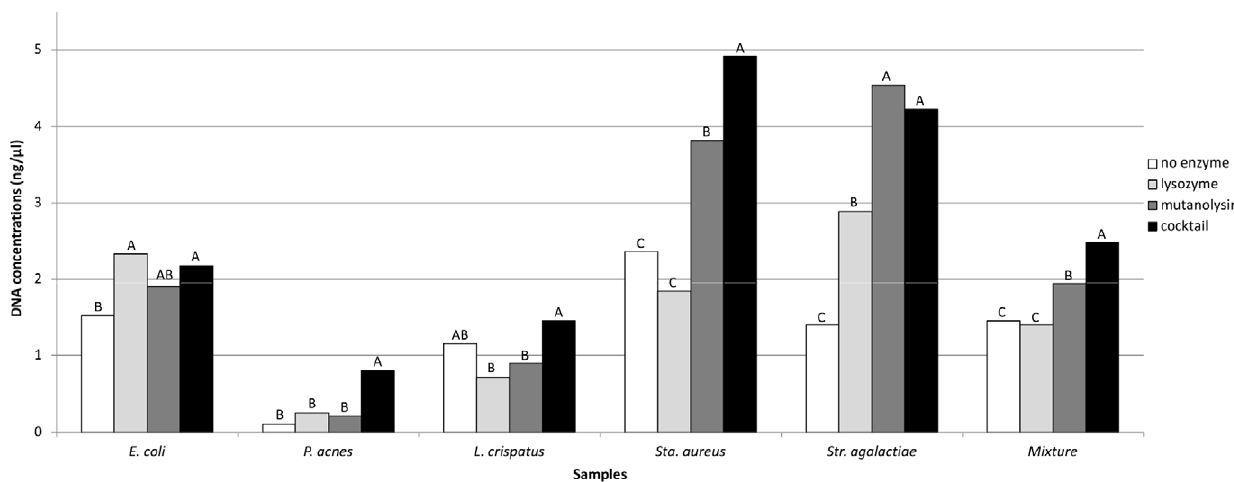
Figure 3. DNA extractions using different enzymatic lysis modes. The mean concentrations (columns) were calculated based on nine replicated extractions per sample per mode. Pair-wise comparisons of DNA concentrations between modes per sample were performed by using Wilcoxon rank sum test. Bonferroni correction was used for multiple testing. Letters at the top of columns indicate whether there is significantly difference between columns per sample. Means with the same letter are not significantly different.